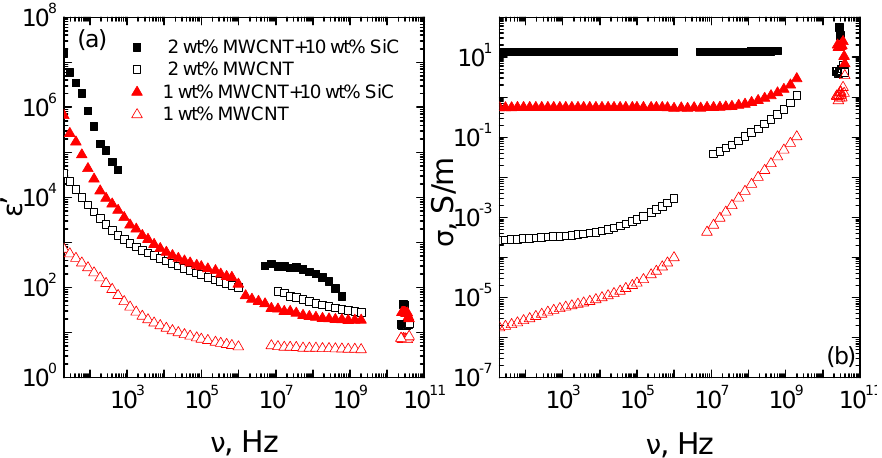
Figure 2. Comparison of ( a ) dielectric permittivity and ( b ) conductivity of the hybrid samples and MWCNT-filled samples as a function of frequency.